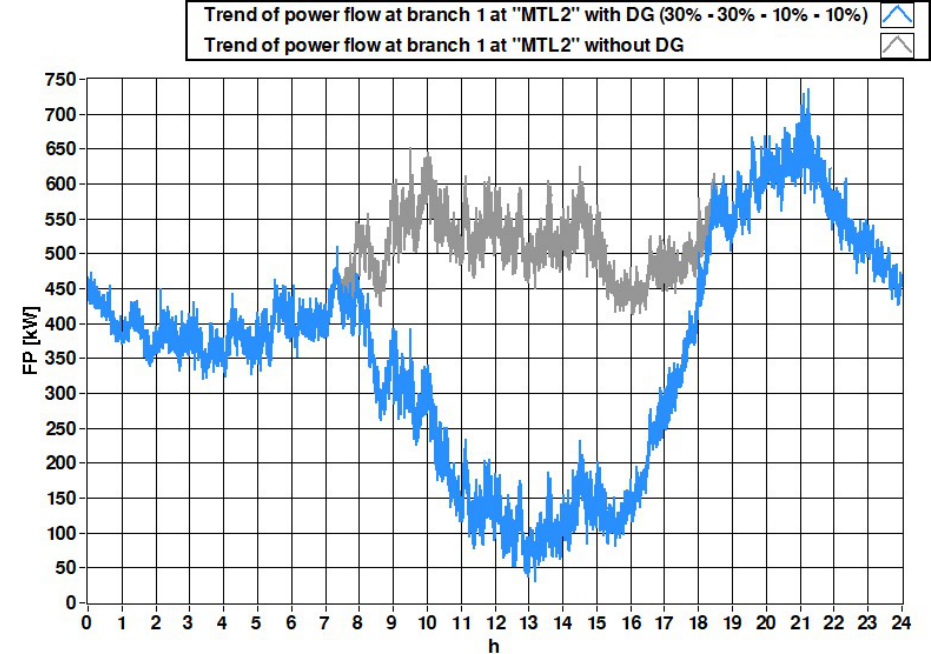
Figure 25. Active power flow during the day 31 May 2018 in branch 1 of the “MTL2” line, both in the absence and with the DG power injection corresponding to Scenario 4.